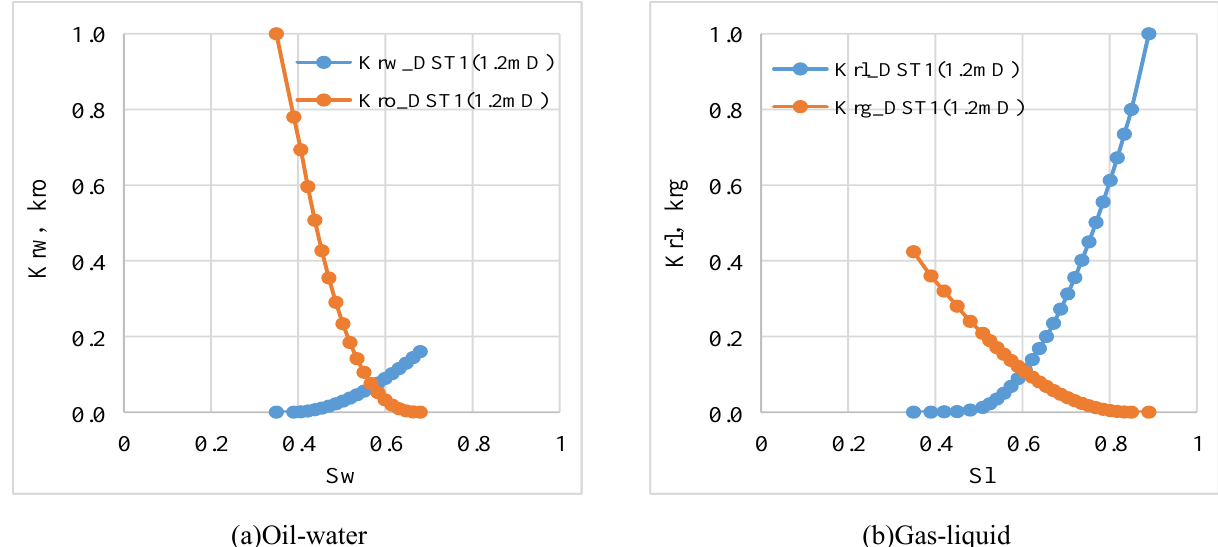
Figure 10—Relative permeability curve of low permeability